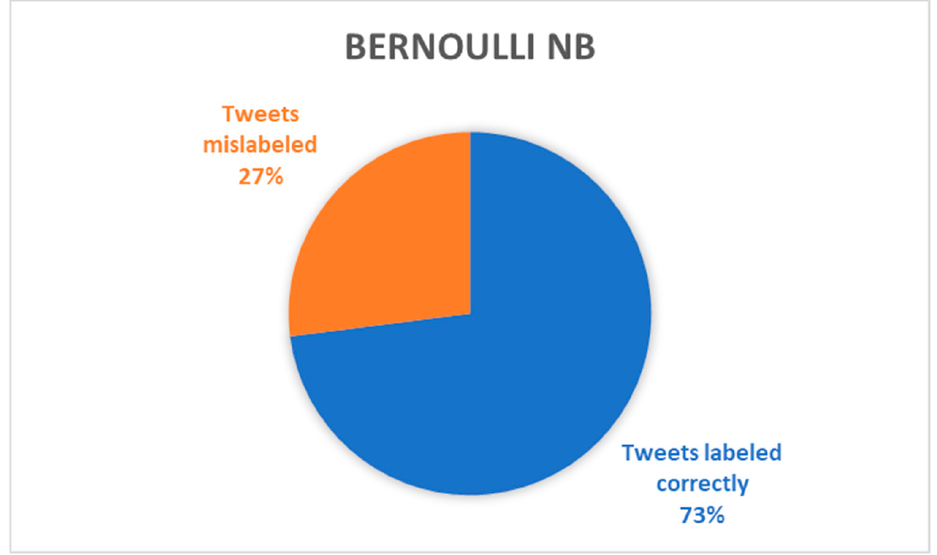
Figure 9. Graphical representation of the accuracy of the Bernoulli NB classifier.